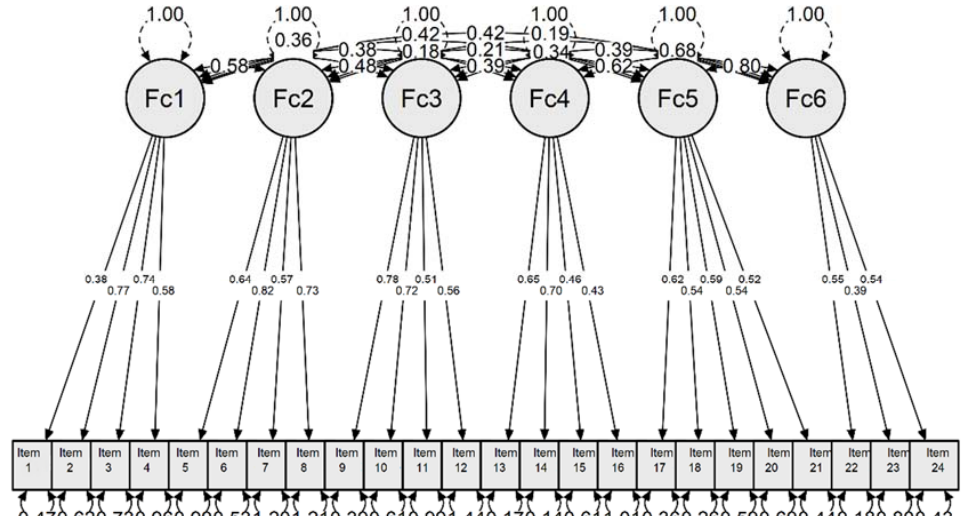
Figure 2. Graphic representation of the model.